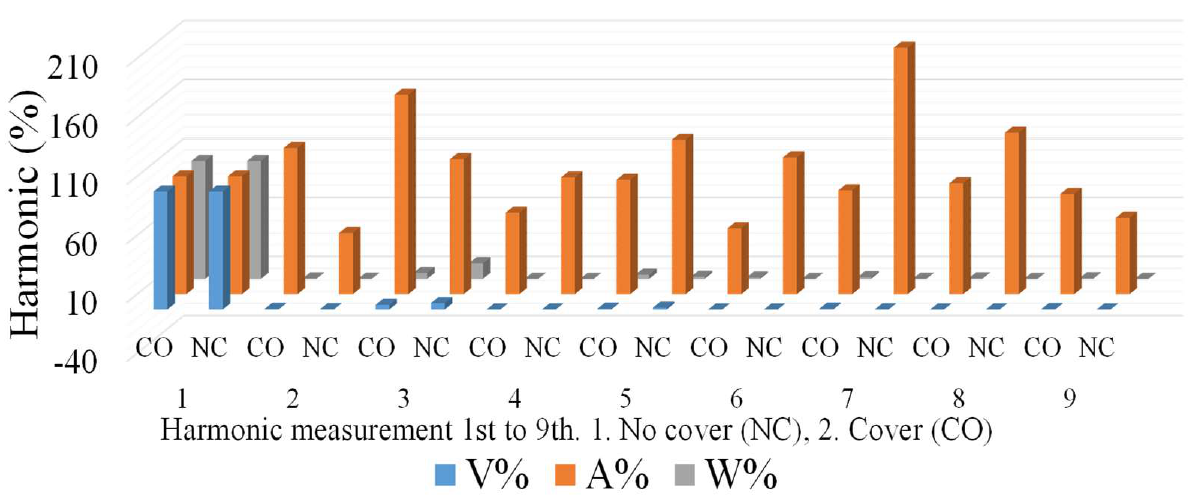
Figure 8. Experimental environment and setup.